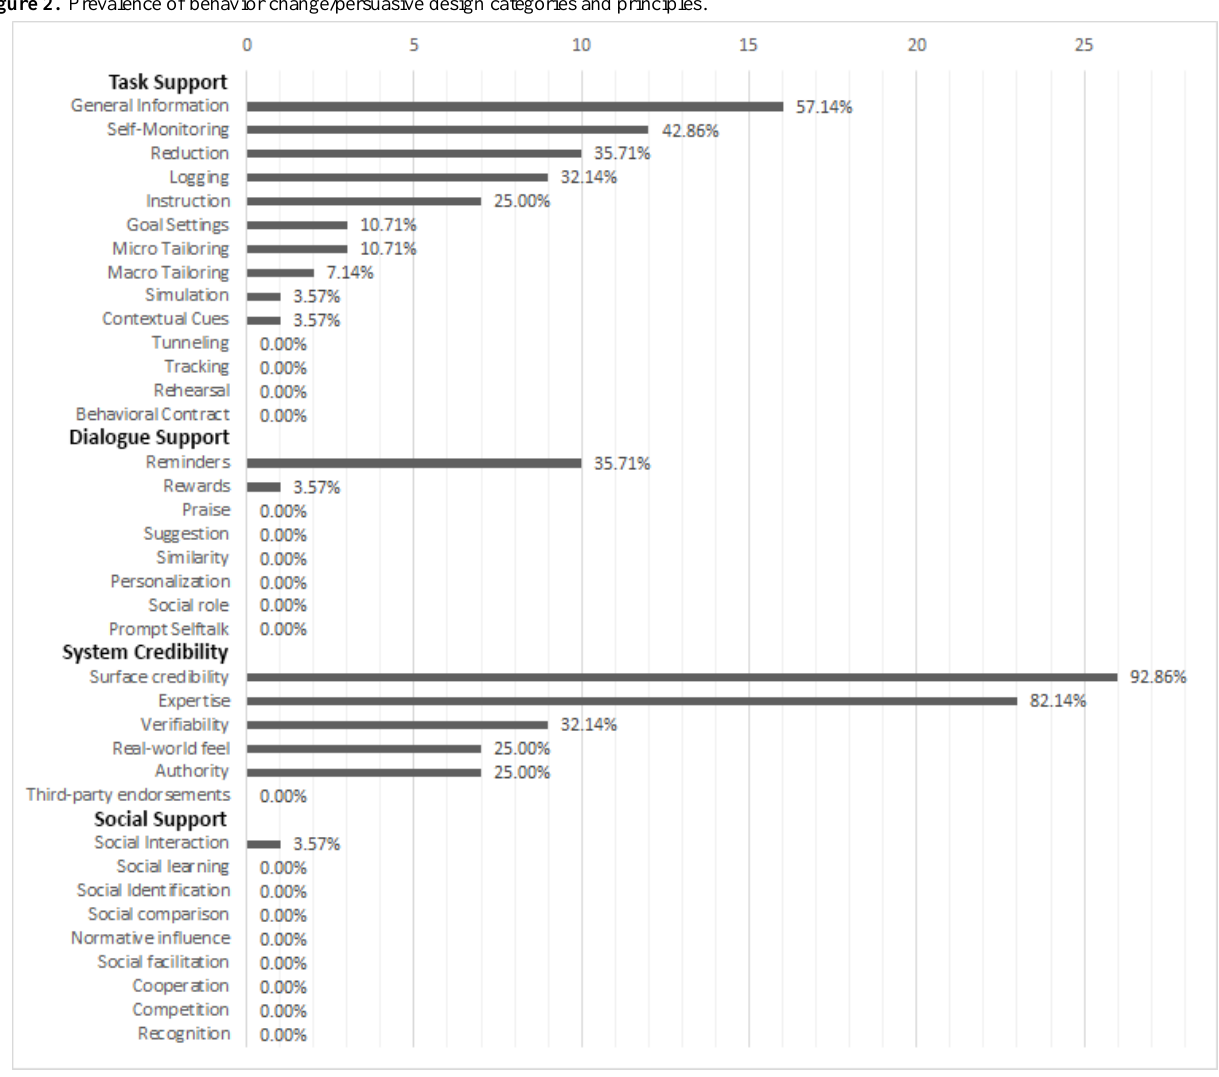
Figure 2. Prevalence of behavior change/persuasive design categories and